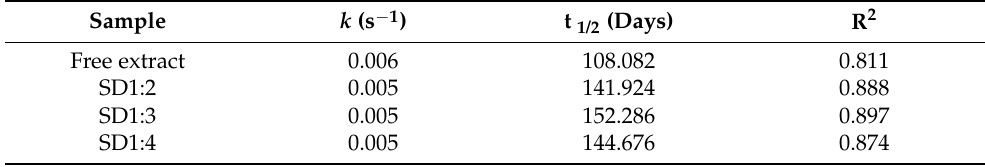
Table 3. Kinetic parameters for carotenoid degradation in non-encapsulated and encapsulated extract during